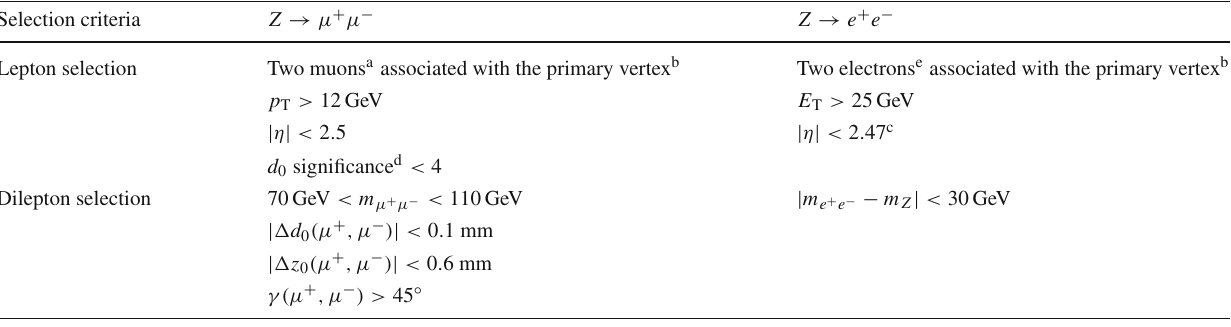
and Z → e + e − event candidates. γ(μ + ,μ − ) is the opening angle between the muons. (cid:7) d 0 (μ + ,μ − ) and (cid:7) z 0 (μ + ,μ − ) are defined as the difference in d 0 and z 0 between the two